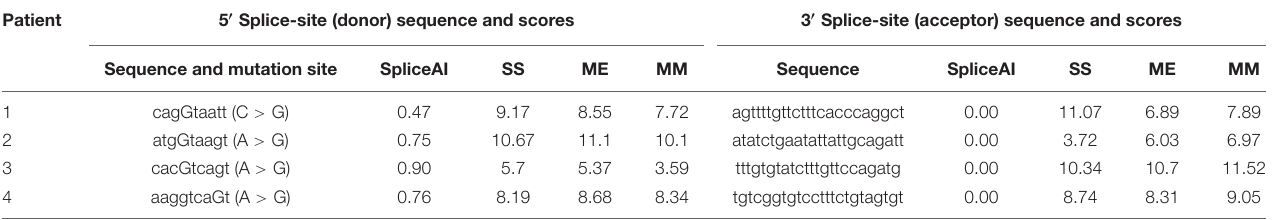
TABLE 3 | Mutation sites, potential donor splice site sequences and splice